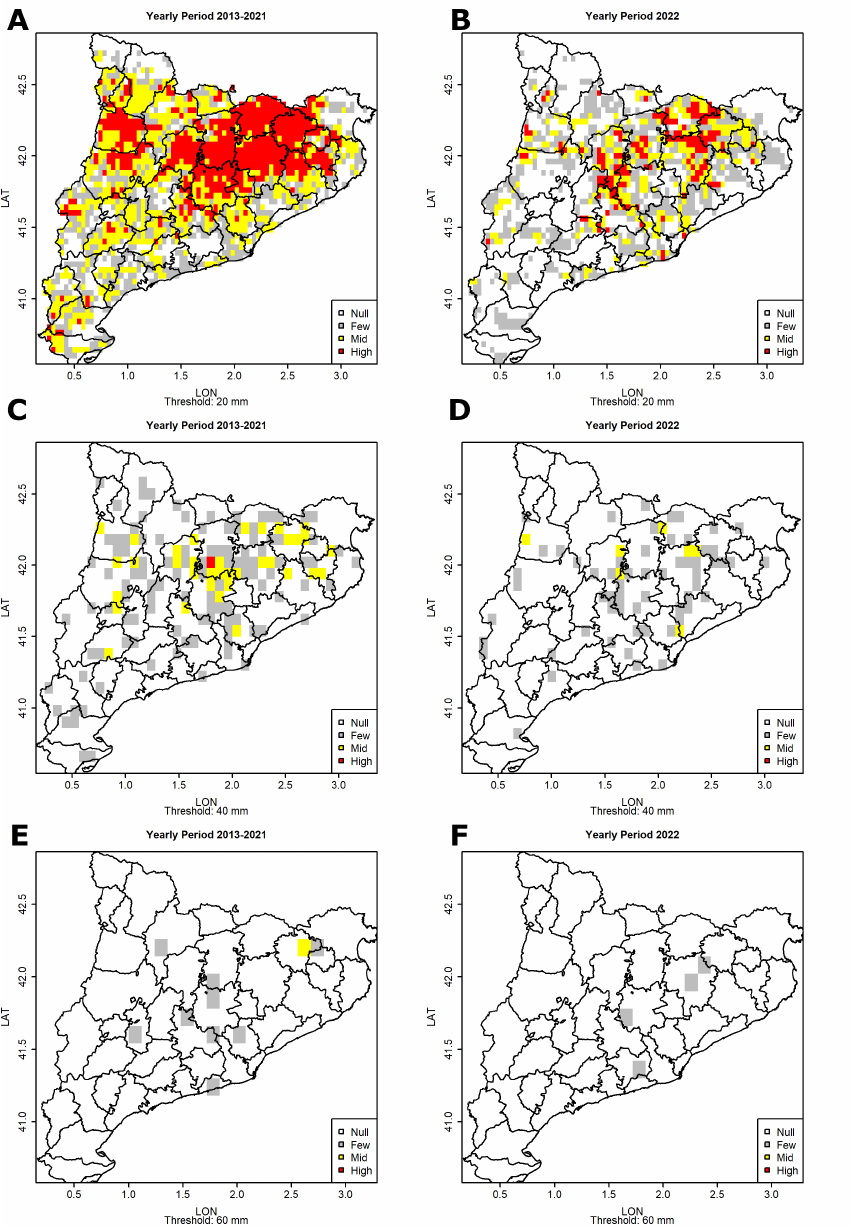
Figure 4. Spatial yearly distribution of the hail swaths for the period of 2013–2021 (pan- els A , C , E ) and 2022 (panels B , D , F ), for the 20 kg/m 2 ( A , B ), 40 kg/m 2 ( C , D ), and 60 kg/m 2 ( E , F ) VIL